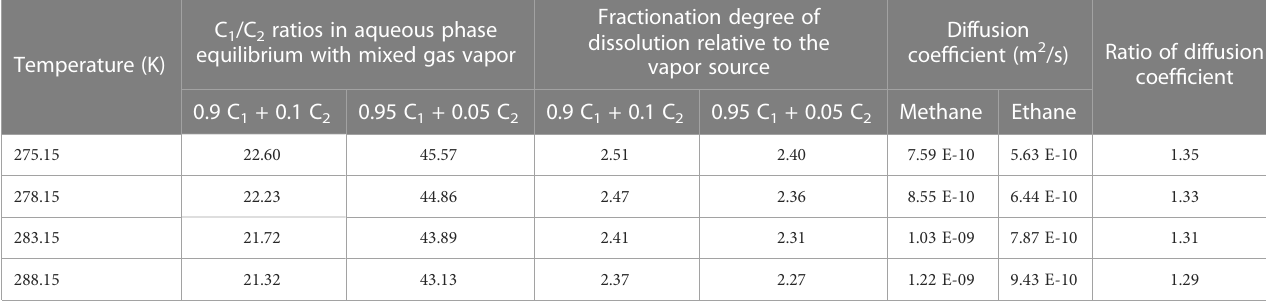
TABLE 4 Dissolution behavior of gas mixture and diffusion properties of methane and ethane under the typical temperatures in GHSZ.